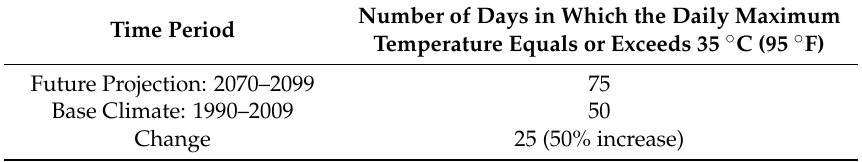
Table 2. Example of corresponding magnitude of change in base and projection time periods for days exceeding T max of 35 ˝ C (95 ˝